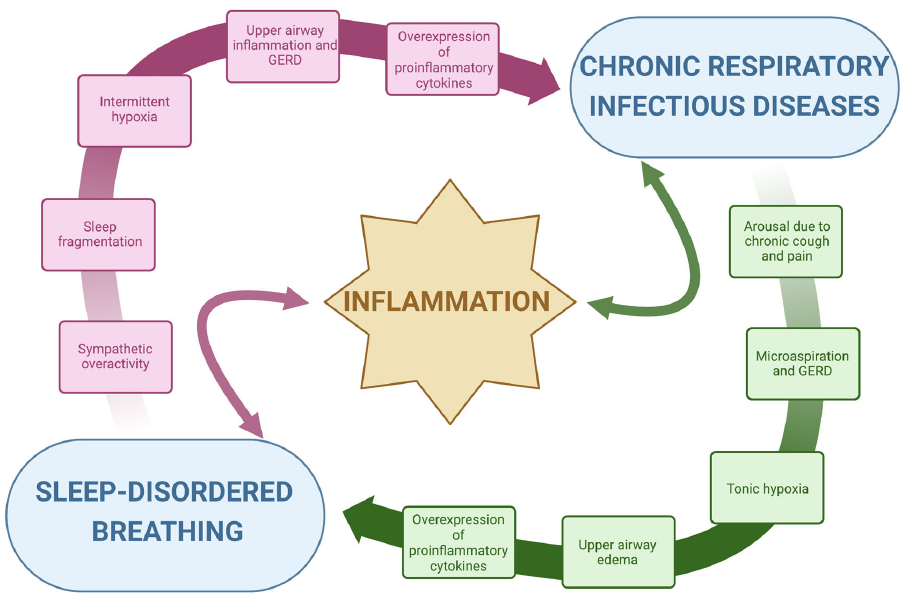
Figure 1. Inflammation cross ‐ talk between chronic respiratory infectious diseases and sleep ‐ disordered breathing.